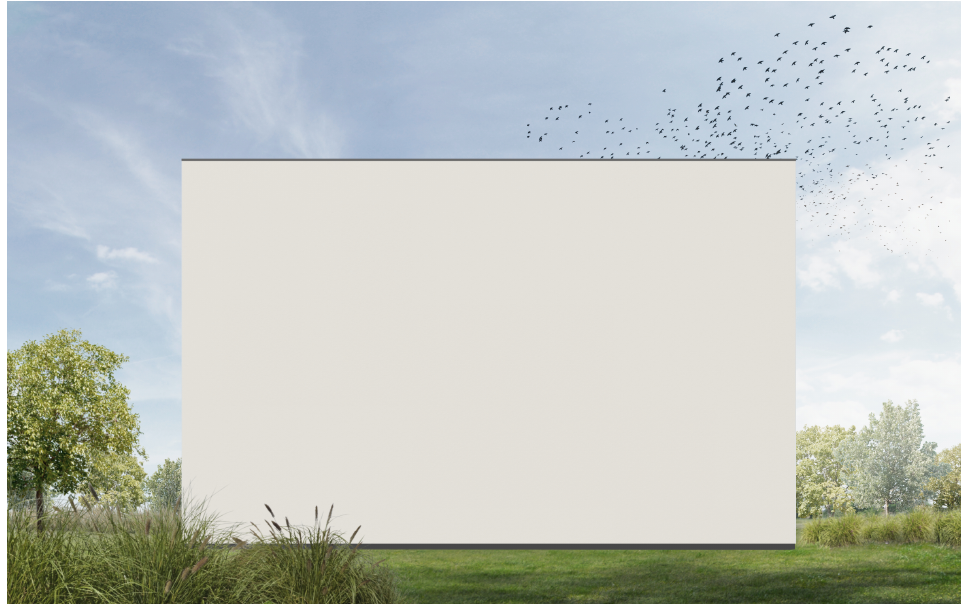
Figure 2. The basis for the stimuli for research.